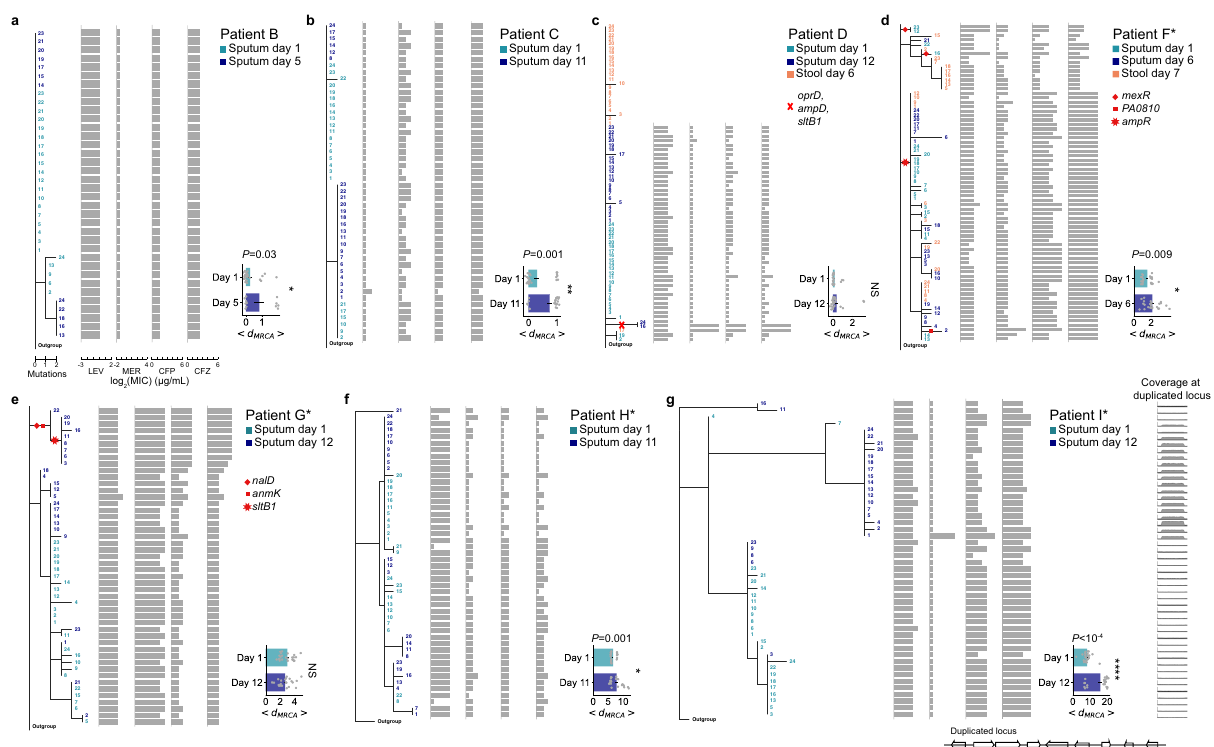
Fig. 3 Phylogenetic analyses of P. aeruginosa populations within each patient and their corresponding antibiotic resistance pro fi les. a – g Left: Phylogenetic trees of P. aeruginosa populations in serially sampled patients: patient B ( a ), patient C ( b ), patient D ( c ), patient F* ( d ), patient G* ( e ), patient H* ( f ), patient I* ( g ). Numbers (rows) correspond to tree leaves that represent an isolate (day 1 sputum in teal, follow-up sputum in dark blue, stool in brown). Scale: mutational events (single nucleotide polymorphisms (SNPs) and indels) from the most recent common ancestor (MRCA) in each patient. A subset of branches associated with antibiotic resistance are marked with red symbols. Middle: Antibiotic resistance pro fi les (horizontal gray bars) in units of minimum inhibitory concentration ( log 2 (MIC); µ g/mL) of individual isolates (rows) aligned to the isolate ’ s position on the tree, shown for levo fl oxacin (LEV), meropenem (MER), cefepime (CFP), and ceftazidime (CFZ). Right: distance to the MRCA (< d MRCA >, x -axis) of isolates (gray dots) at each time point ( y -axis, days of infection). Mean (horizontal bars) and standard error (error bars) calculated over n = 24 biologically independent isolates per sputum or stool sample (exception: n = 12 isolates in Day 5 sputum of patient B ( a )). Signi fi cance, one-tailed permutation test: P = 0.03 ( a ), P = 0.001 ( b ), P = 0.009 ( d ), P = 0.001 ( f ), P < 10 − 4 ( g ). NS not signi fi cant. g Far right, bottom: schematic showing the relative copy number ( y -axis) of a ~34 kb duplicated chromosomal region ( x -axis) that encodes, among others, genes of the pyoverdine pathway